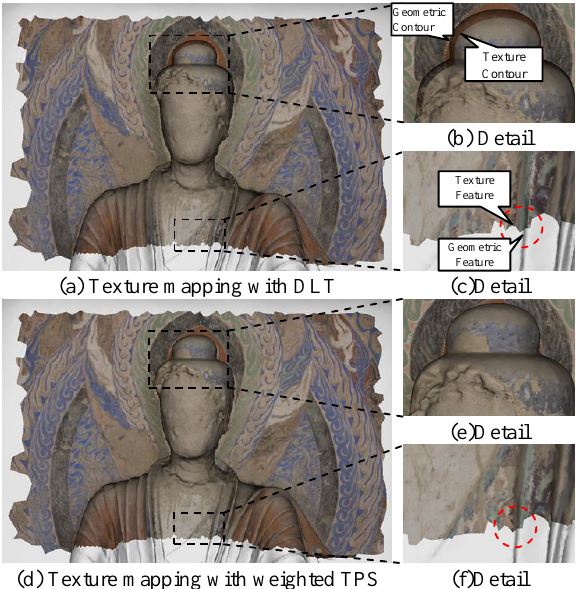
Figure5. Comparison of texture mapping results based on